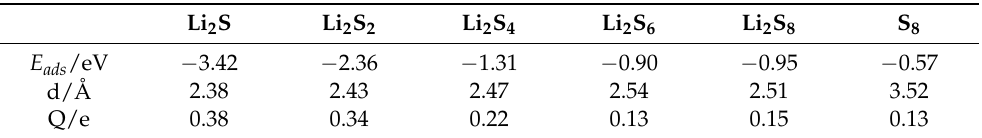
Table 1. The adsorption energy ( E ads ), shortest distance between Li 2 S x species and Ti 2 NS 2 , the charge transfer (Q, a positive value means that the substrate loses electrons from Li 2 S x , a negative value is the opposite) when Ti 2 NS 2 adsorbs Li 2 S x species.